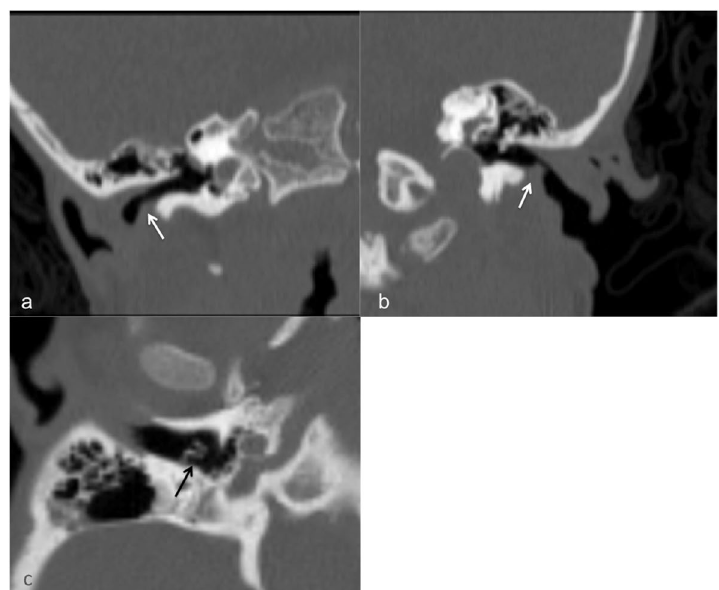
Fig. 3 Coronal oblique reformatted CT image reveals narrowing of right ( a ) and left ( b ) EAC (white arrows). Tympanostomy tube (black arrow) on right tympanic membrane is seen on axial CT